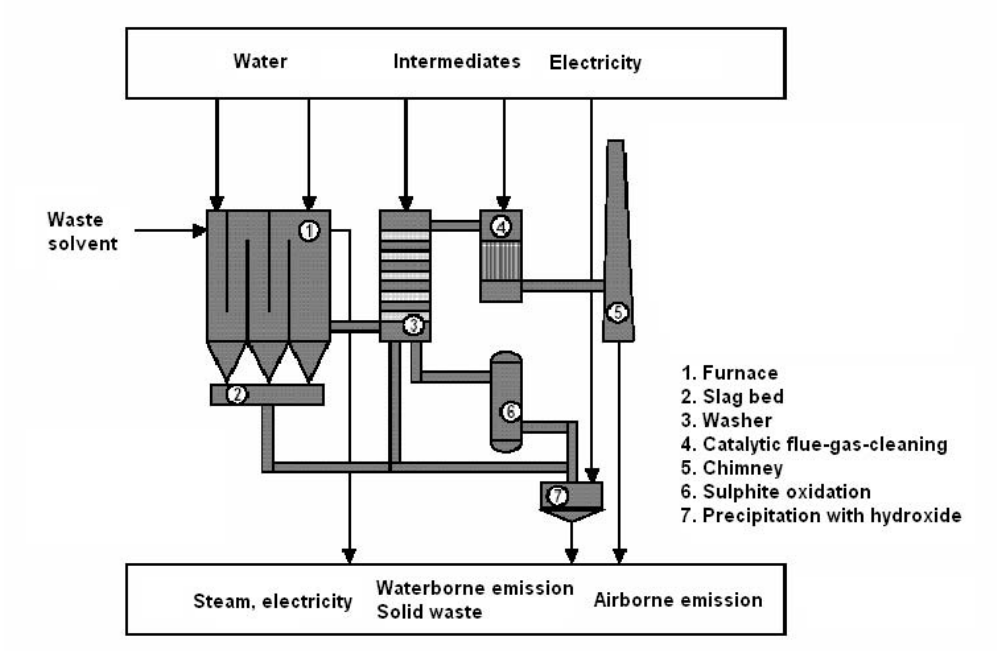
Fig. 3 Structure of a typical waste solvent incinerator